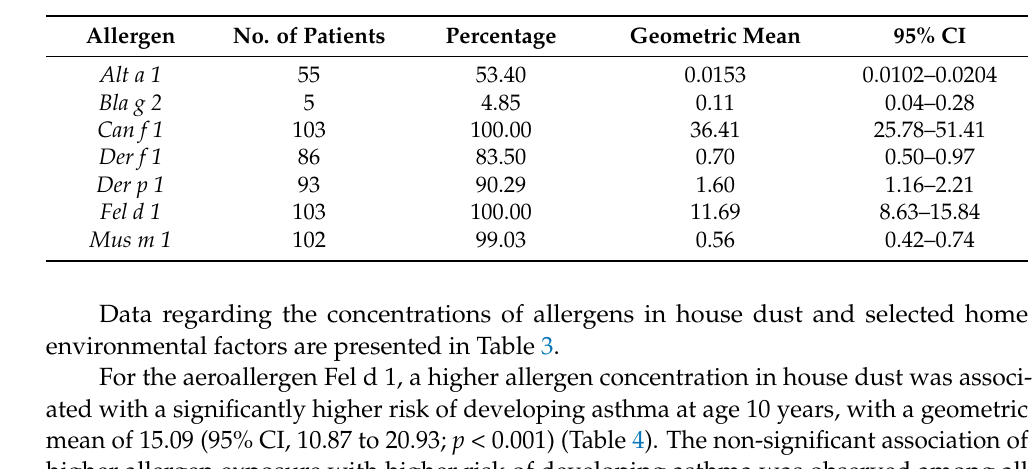
Table 2. Descriptive statistics for the investigated allergen prevalence (%) and concentrations (ng/mL) in the studied